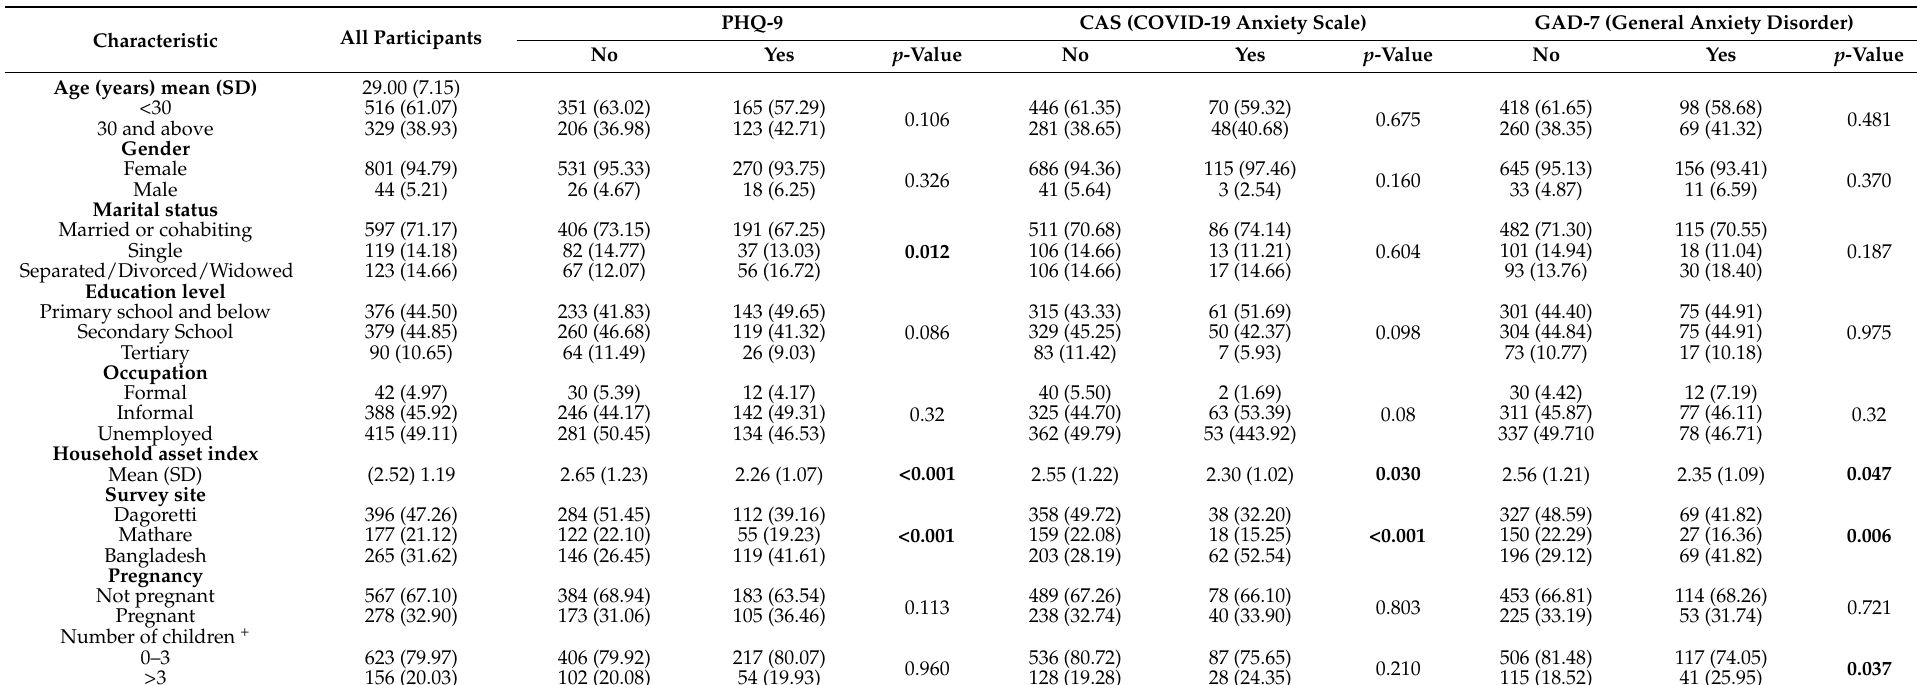
Table 1. A summary of socio-demographic variables stratified by participants’ mental health